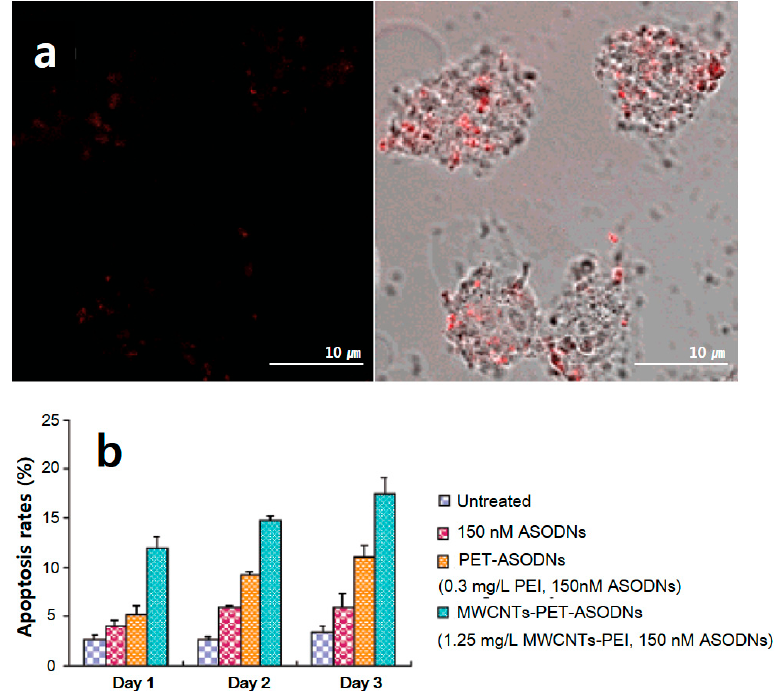
Figure 4. ( a ) Confocal fluorescence image of HeLa cells taken 24 h after 1 h-long incubation with MWCNTs-PEI-ASODNs-CdTe at 37 ◦ C (left), and the merged image (right); ( b ) Flow cytometric analysis. After culturing the cells in the presence of naked ASODNs, PEI-ASODNs, and MWCNTs-PEI-ASODNs, cell viabilities up to day 3 were analyzed by staining the cells with propidium iodide (PI). Reprinted with permission from Ref. [83]. Copyright (2016) American Chemical Society.